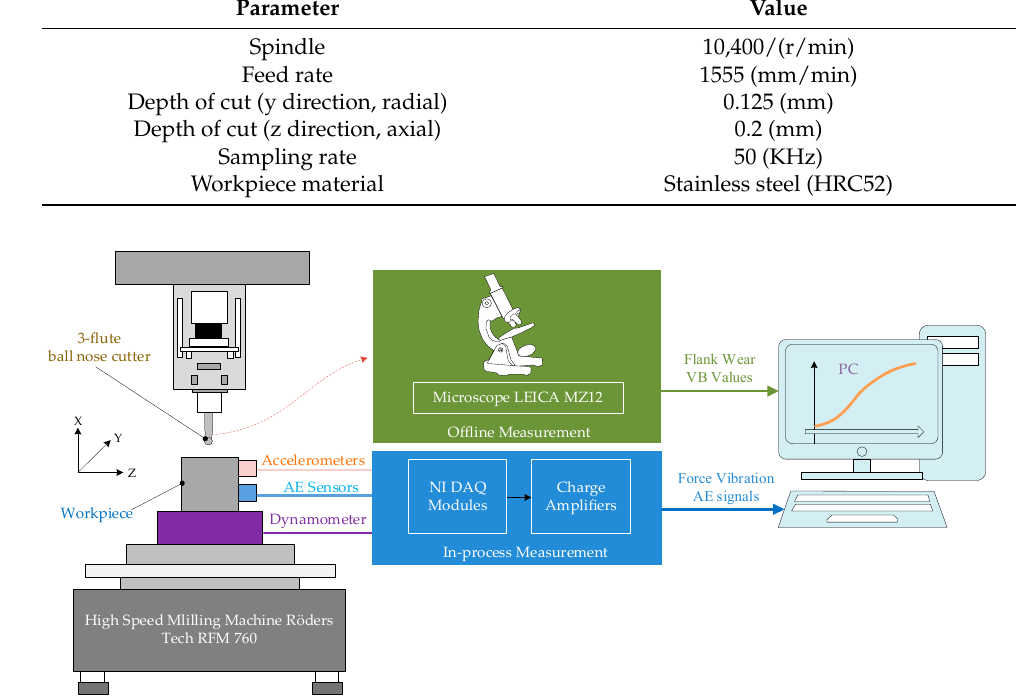
Figure 9. Illustration of the experimental setup. Table 1. Main equipment of the experimental setup.